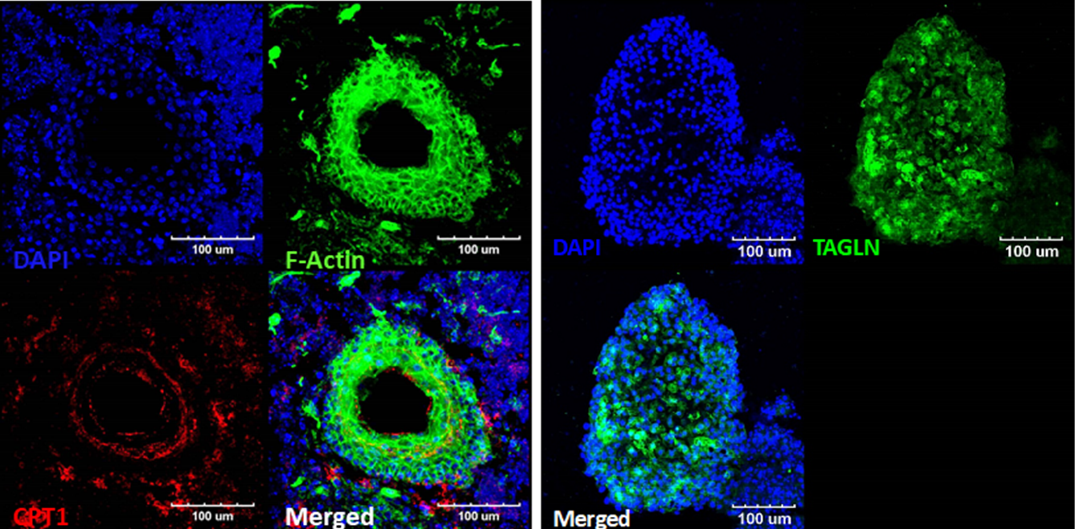
Figure 7. Epifluorescence analysis and incidence of ‘beating’ structures (organoids) ( A ) Results of an epifluorescence analysis of the beating structures. The right image shows the expression of TNNI1 (red; troponin I; slow skeletal muscle gene expressed in cardiomyocytes). The expression of dense F-actin (right image) and TAGLN (left image) (green; transgelin; smooth muscle cell marker) in this structure suggests a muscular composition. Considering the expressed markers, we speculated that these structures were cardiac-mimicking organoids. We compared the number of these beating structures (possible cardiac organoids) between the control (conventional otic differentiation) and CHIR (+) differentiation groups ( B ). No beating organoids were observed in the control group, but they were observed in about 30% of all differentiated organoids in the CHIR-treated group. Scale bars indicate 100 µm. (* p < 0.05).